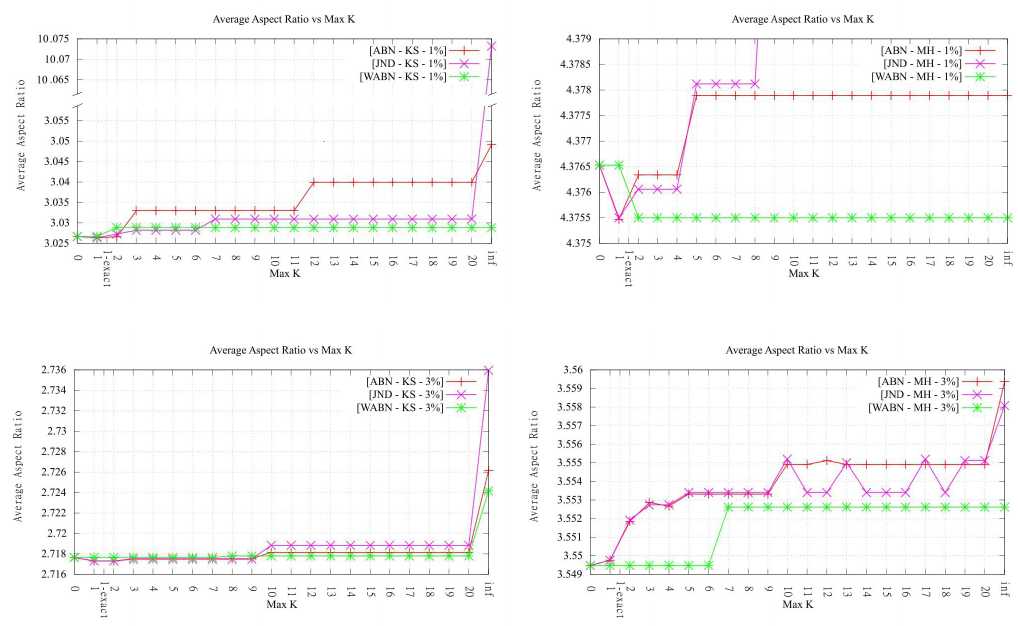
Figure 10. Average aspect ratio comparison between all criteria for Kinzel Springs ( left ) and Moorehead SE ( right ) as the maximum order k increases (excluding exact algorithms). In each column, from top to bottom: 1% and